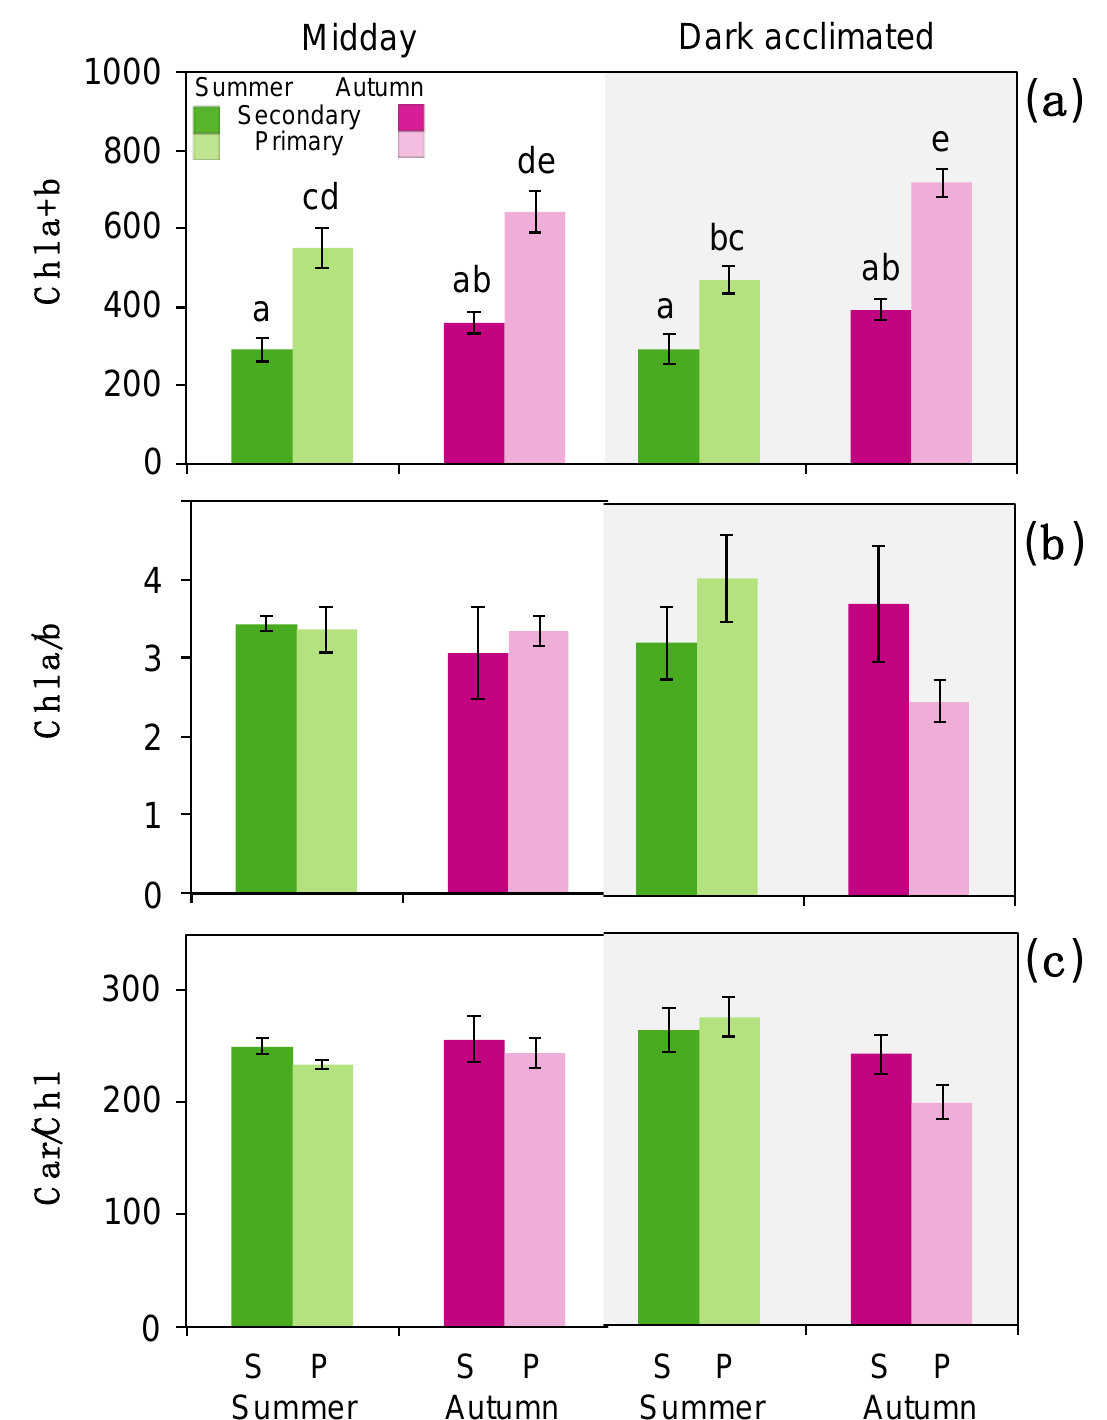
Figure 6. Photosynthetic pigment composition of P. canariensis needles as measured in the field at midday, or after 16 h of dark acclimation (at ≈ +20 ◦ C). ( a ) Total chlorophyll content in µ mol m − 2 . ( b ) Ratio of Chl a to b in mol mol − 1 . ( c ) Total carotenoids content per chlorophyll in mmol mol − 1 . Data are mean ± SE ( n = 5). When significant, differences among needle types, daytime and seasons are depicted with different letters above the bars ( p < 0.05). No significant differences among needle types, daytime or seasons were found for Chla/b ratio ( b ) nor for Car/Chl ratio ( c ). Gas exchange results are shown in Figure 7. Contrary to our expectations, net car- bon assimilation of primary and secondary needles of P. canariensis did not differ signifi- cantly, even if primary needles showed slightly lower values (i.e., 1.8 ± 0.5 in primary